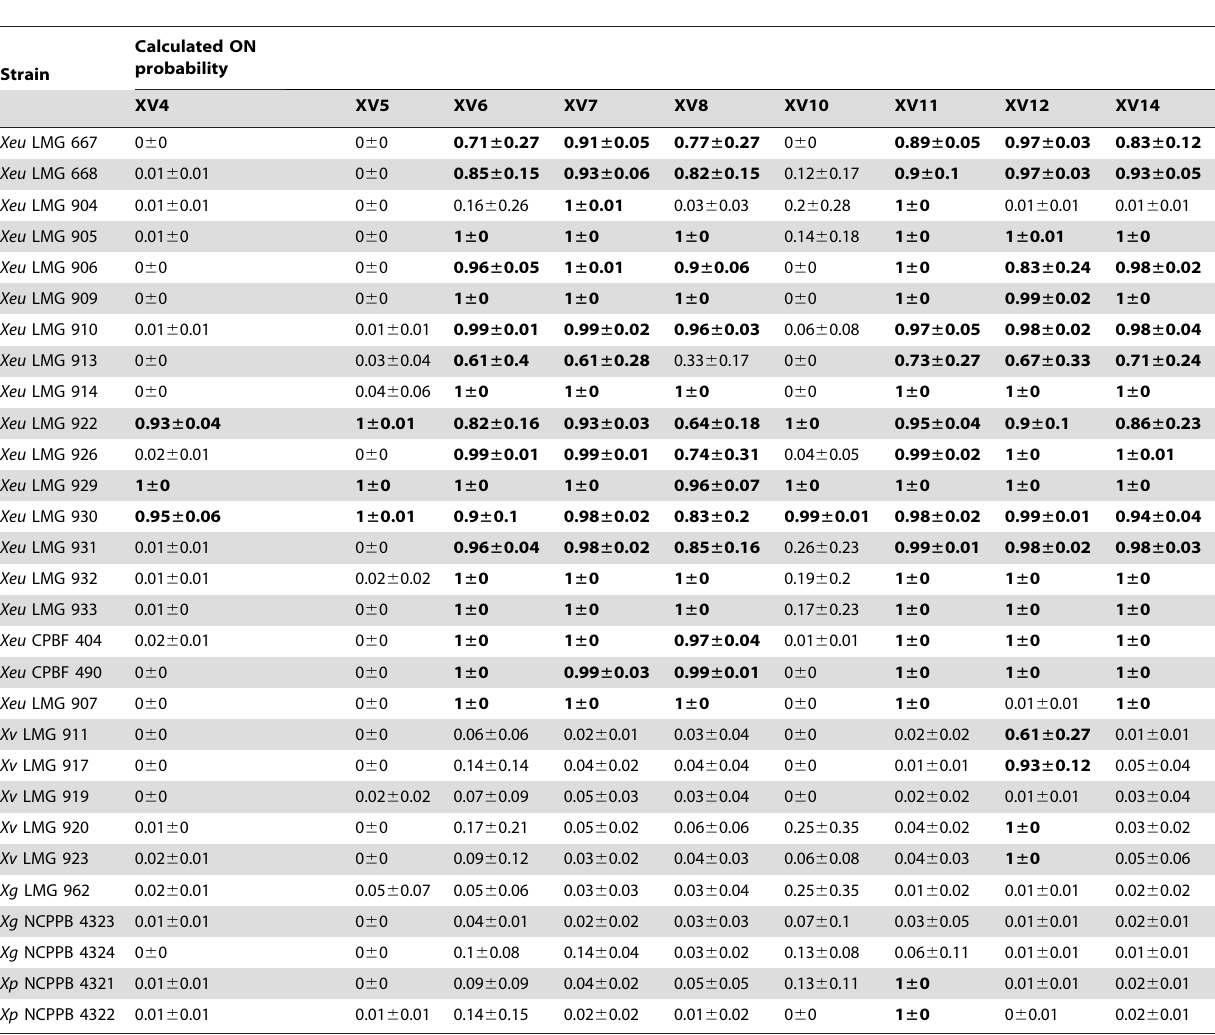
The displayed values refer to: average probability 6 standard deviation. Probabilities with an average value higher than 0.5 are highlighted in